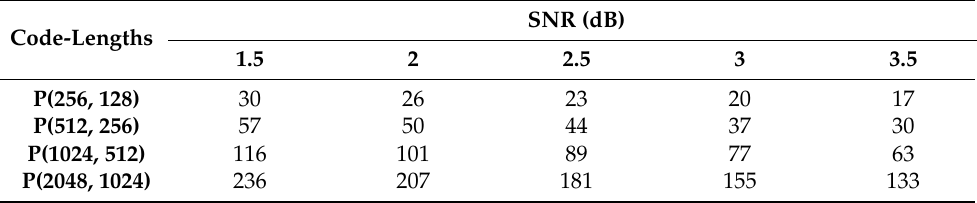
Table 2. Average frequency of event γ at different SNRs and code-length results for 10 7 blocks.